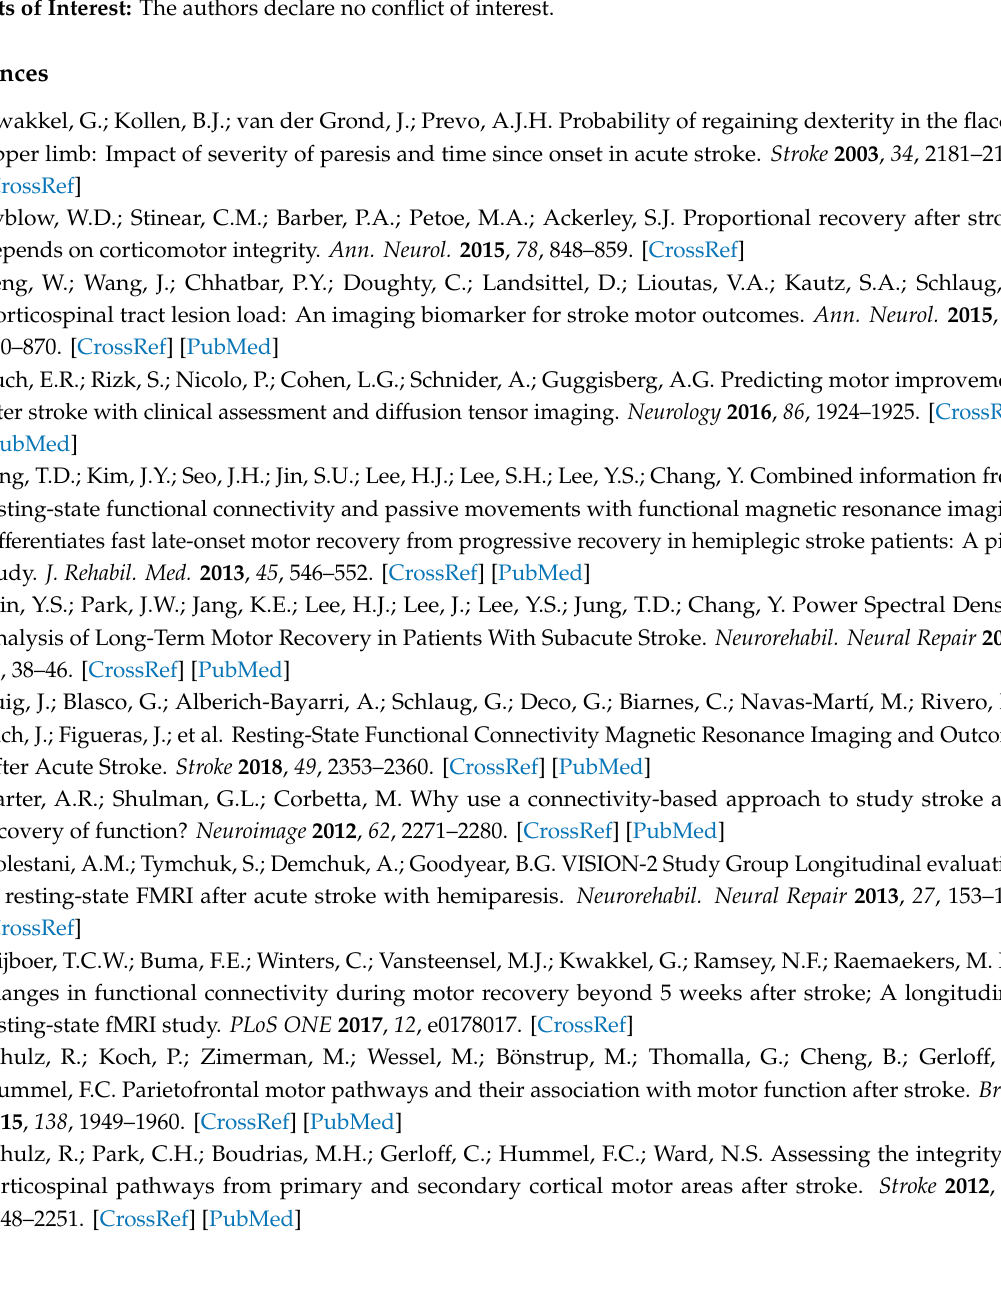
Table S1: Individual ROI coordinates obtained from